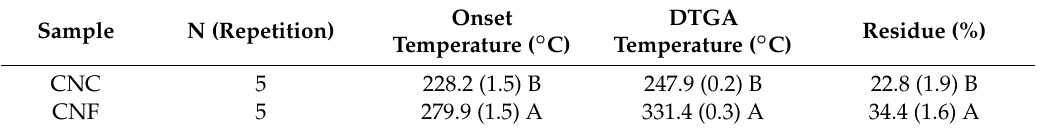
Table 4. The comparison of thermogravimetric properties of CNF and